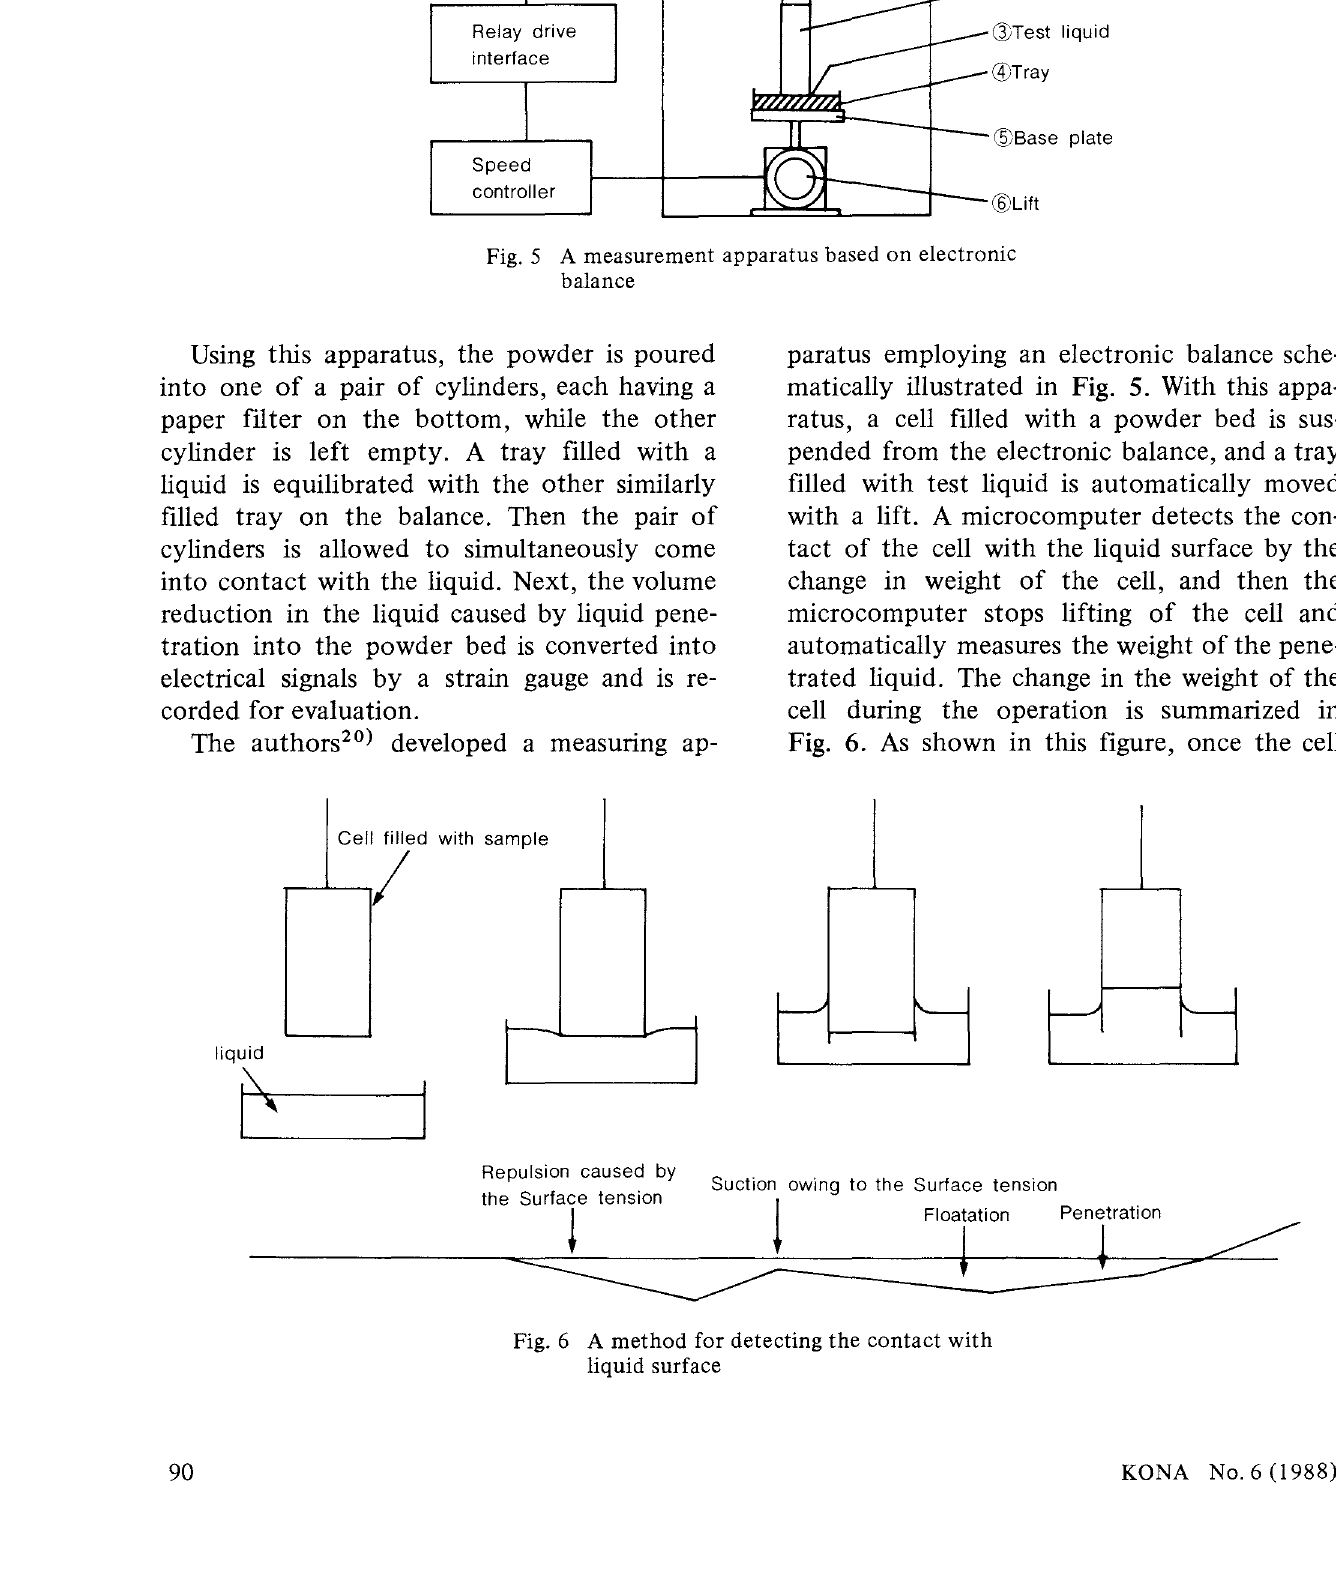
Fig. 6 A method for detecting the contact with liquid